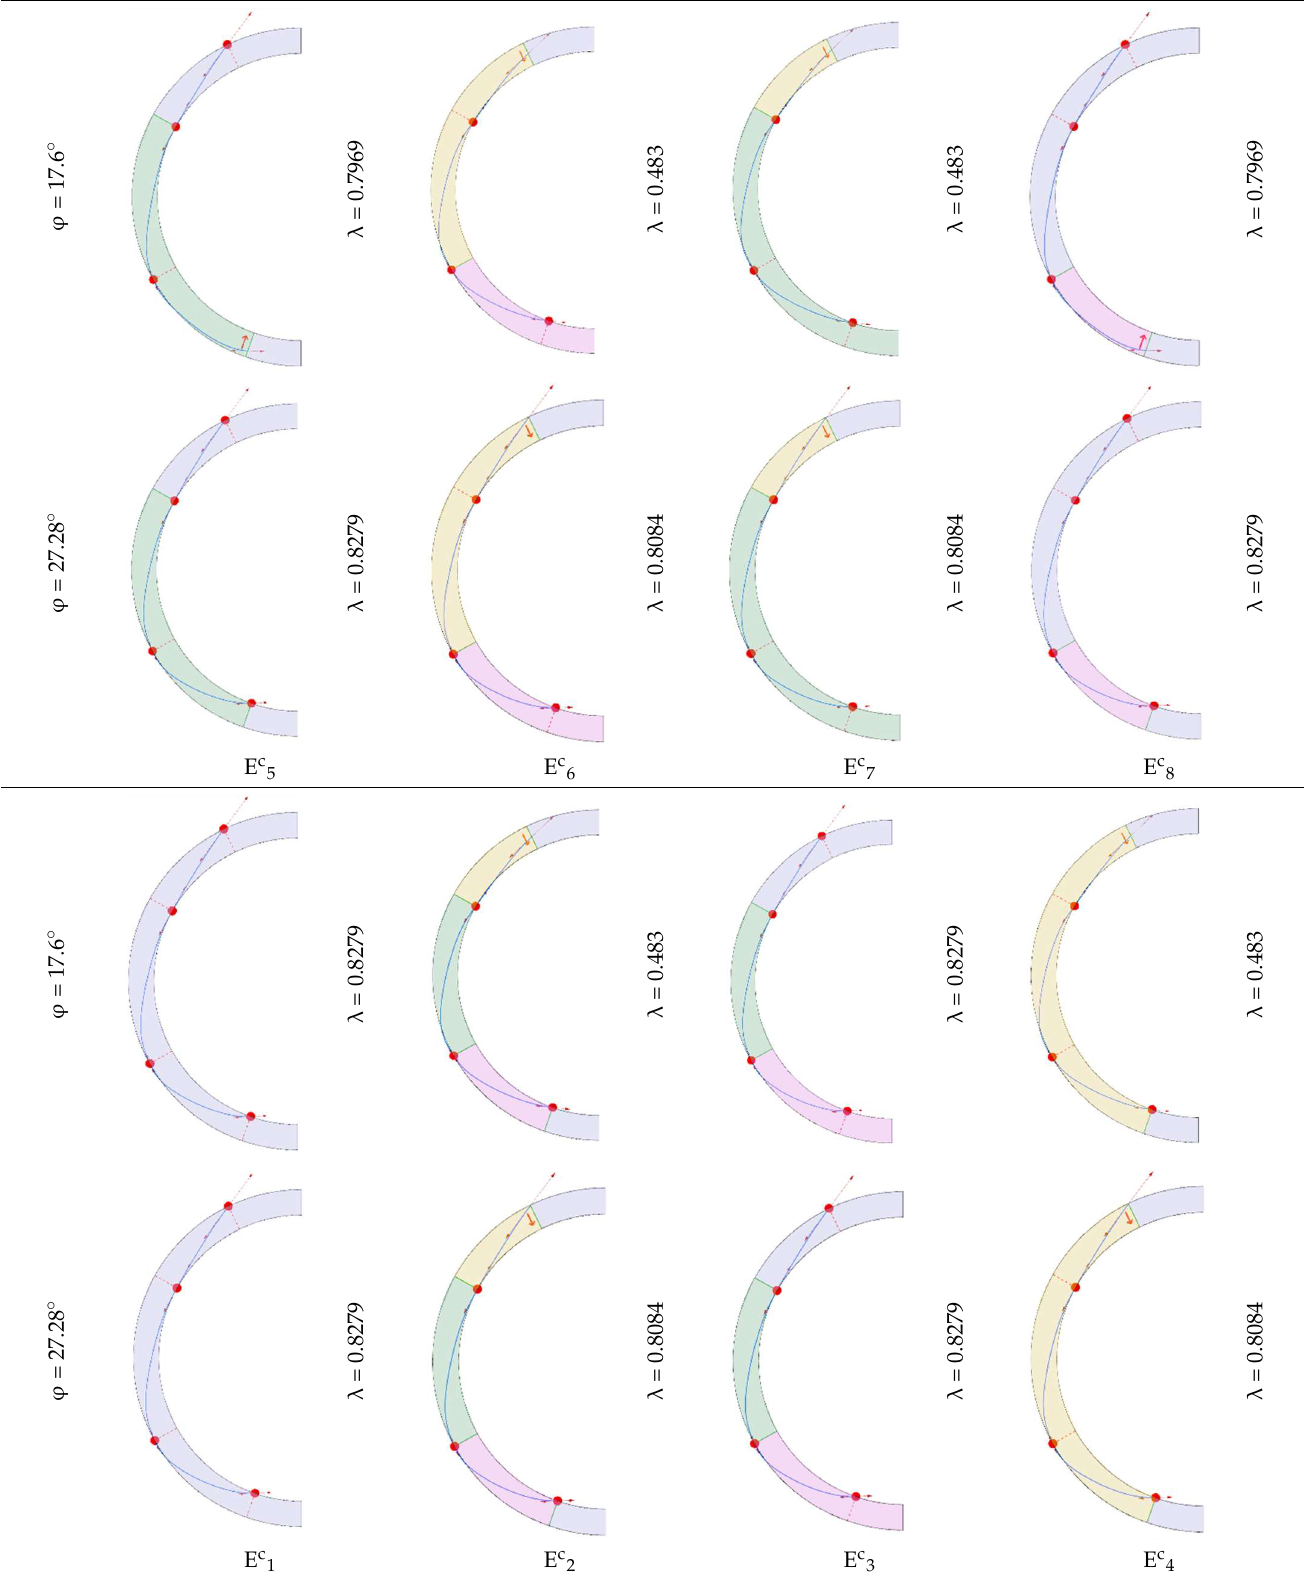
Table 3. Computed load factors of sixteen segmental arches for friction angles of 27.28 ◦ and 17.6 ◦ .